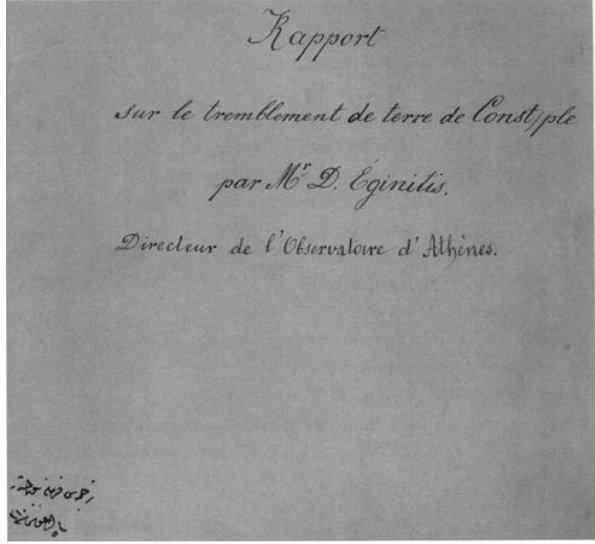
Figure 3f. Cihannüma (Universal Geography) written by Katip Celebi (Haji Khalifa) in 1776.